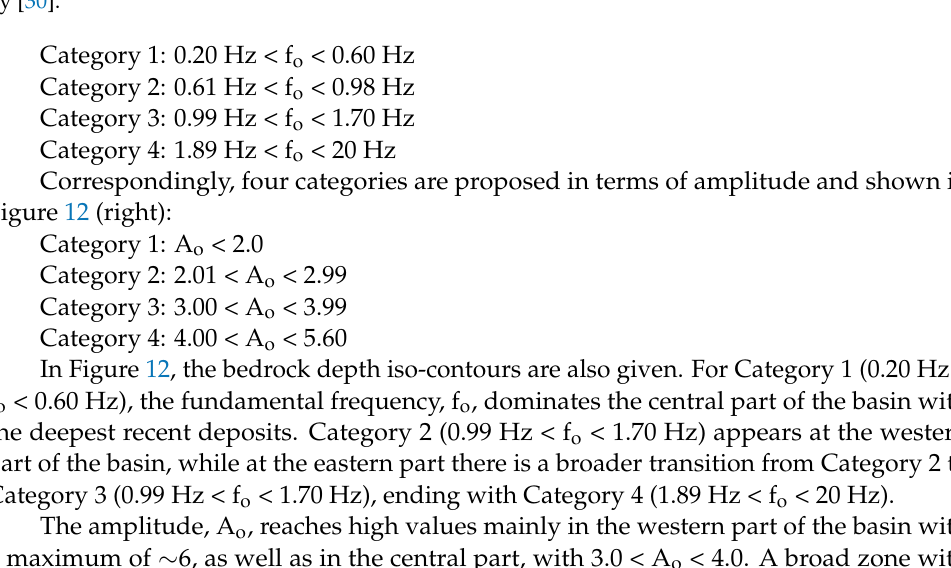
Figure 12. Distribution of the fundamental frequency, fo, in the city of Durres ( left ); Distribution of the corresponding to the fundamental frequency, A o , amplitude ( right ). Bedrock depth iso-contours by [30].